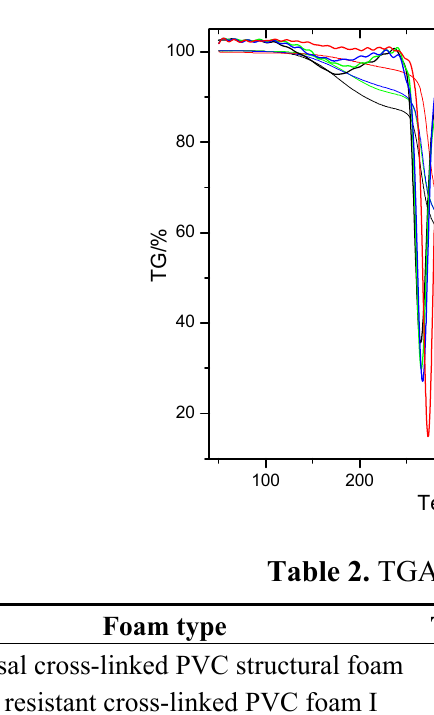
Figure 3. TGA/DTG curves of foam plastics ( 1 ) universal structural foam, ( 2 ) heat